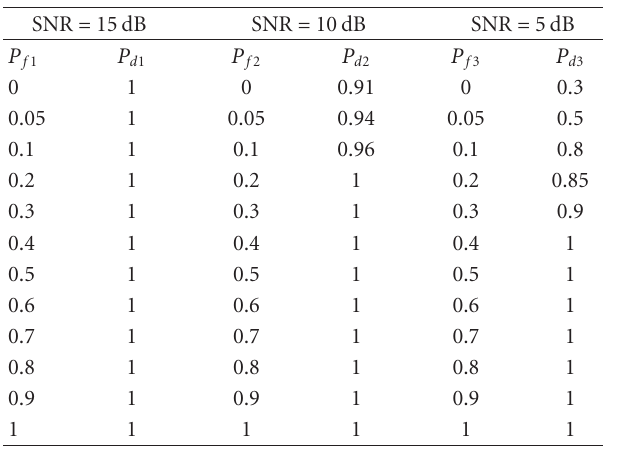
Table 4: Receiver operating characteristics (ROCs).